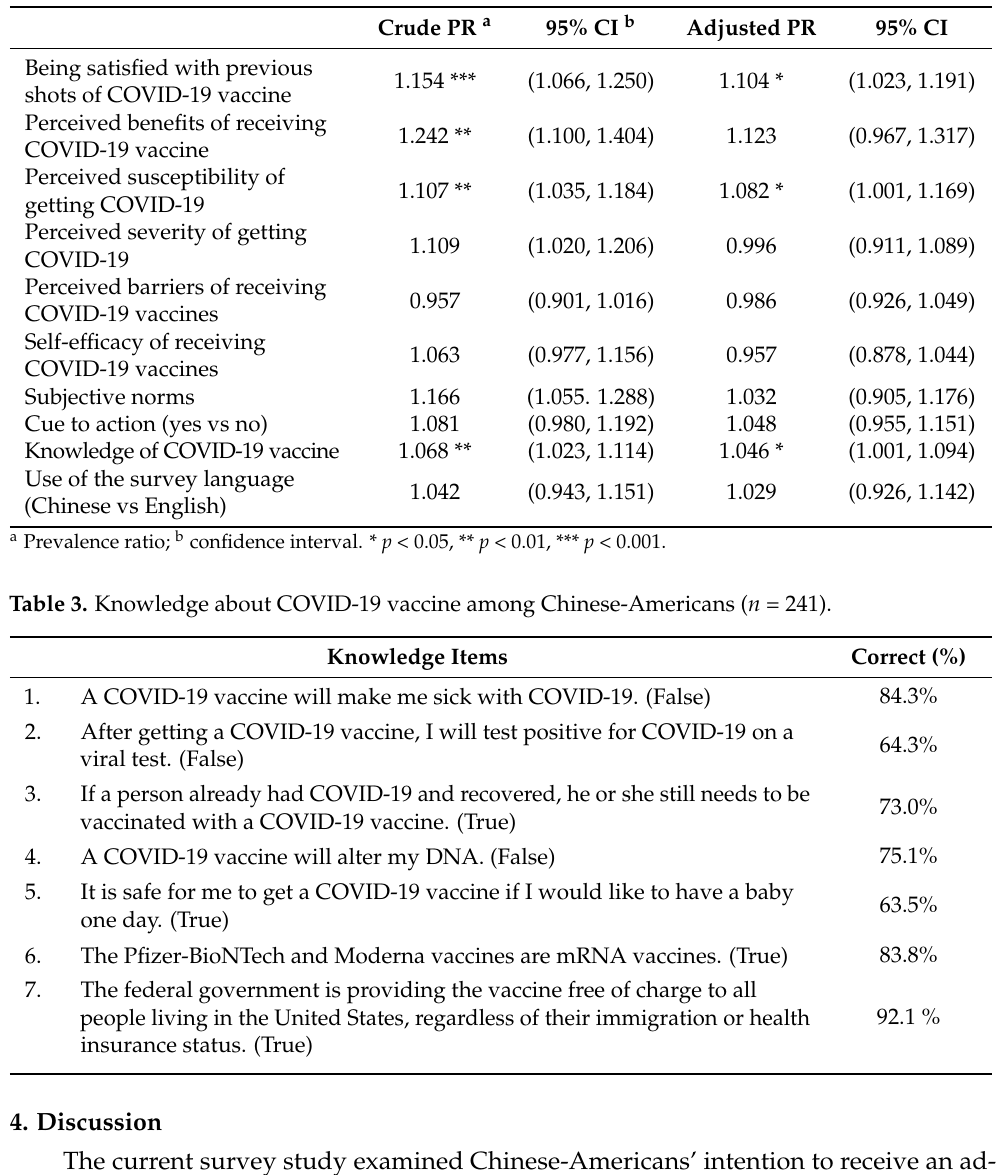
Table 2. Predictors of intention to receive annual dose of COVID-19 vaccine among Chinese- Americans ( n = 241).